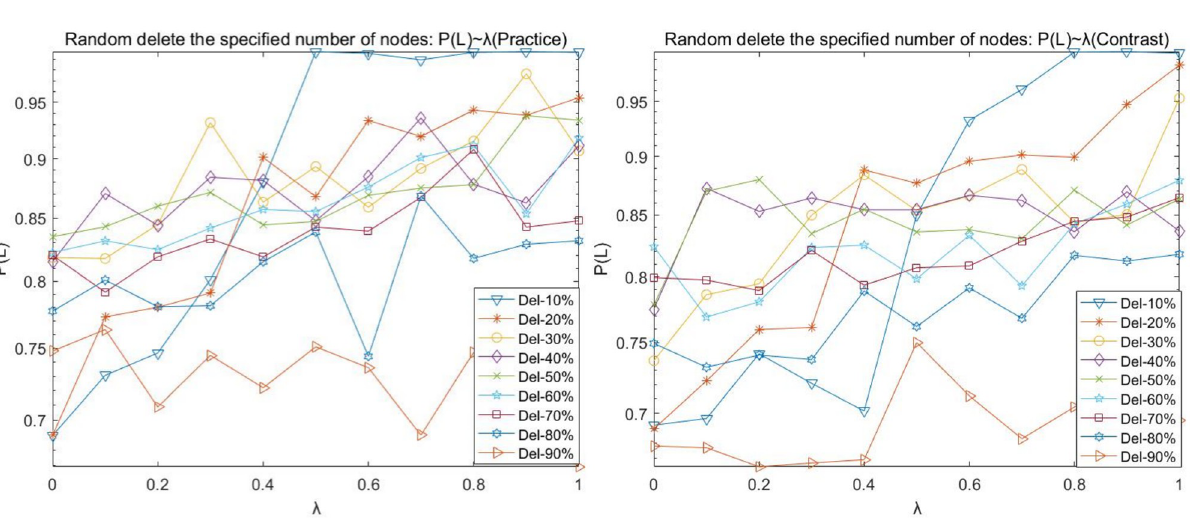
Fig 3. Random disruption- P ( L ) with λ variation